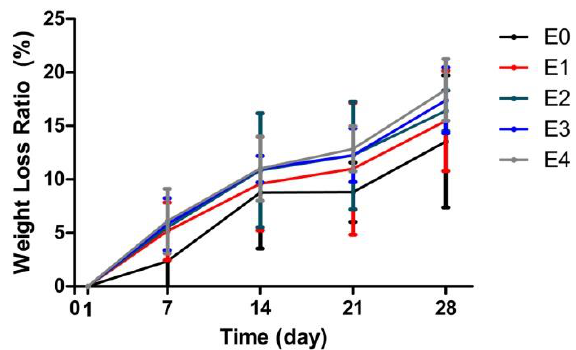
Figure 4. Weight loss ratios of ESM/GG hydrogels with different concentrations of ESMs to evaluate their degradability. Error bars mean the standard deviation (n = 4).